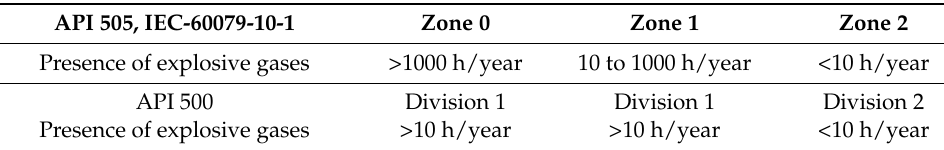
Table 5. Zone and Division systems: a comparison.